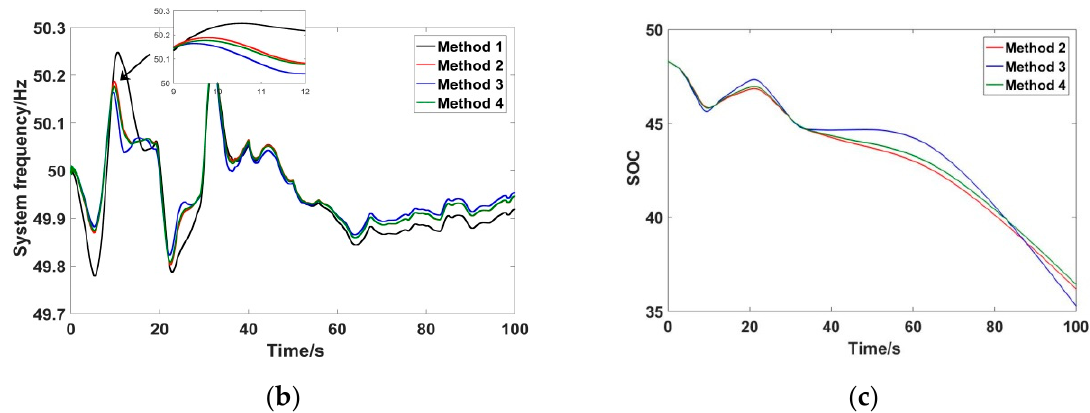
Figure 20. Results of continuous load disturbance (Load A). ( a ) Continuous load disturbance curve. ( b ) System frequency curves under continuous load disturbance. ( c ) SOC curves of the energy storage system.